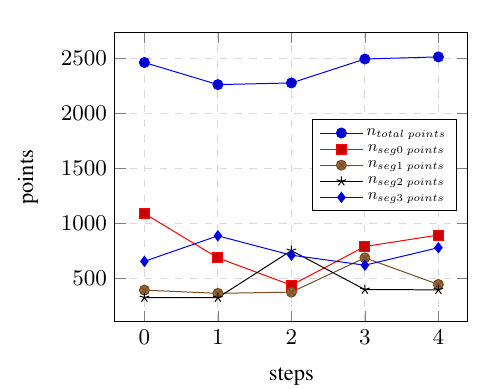
Figure 5. Plot showing the number of points captured at each step when flying the autonomous segment inspection with a radius of 2 m ( 1 m distance to the object surface) with ω = 0 . 25 rad/s